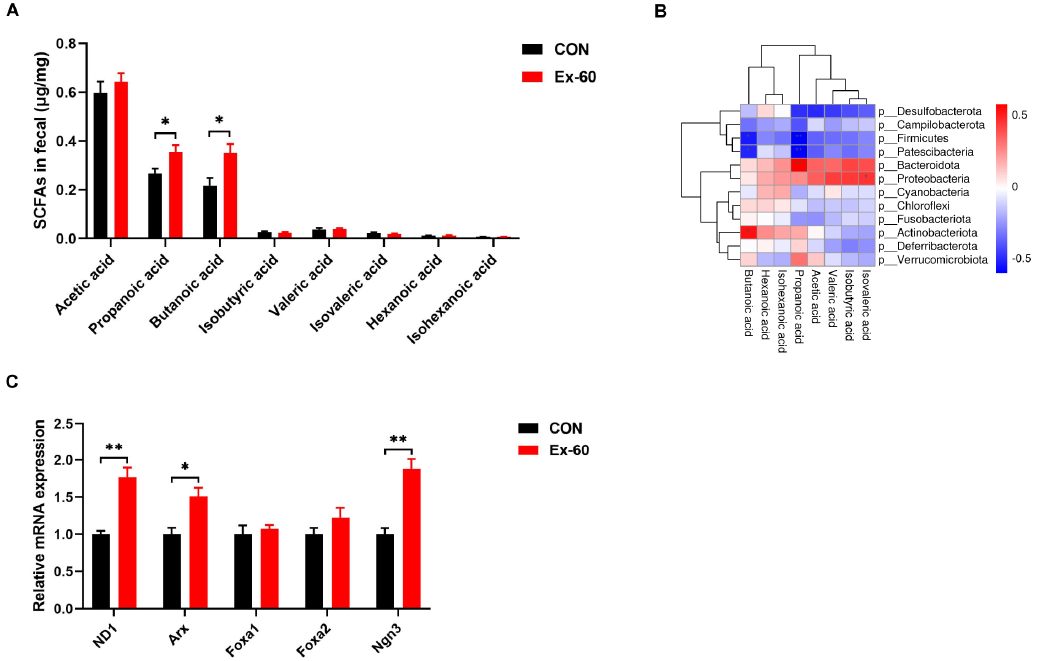
Figure 4. Two ‐ week swimming training alters short ‐ chain fatty acid profile. ( A ) SCFAs content in fecal samples, n = 8–10. ( B ) Pearson correlation analysis of SCFAs with gut microbiota on phylum level. Red indicates a positive correlation, blue indicates a negative correlation, and white indicates no correlation. ( C ) qPCR analysis of the expression of the regulators of L cell proliferation in colon samples. Data are expressed as the mean ± SEM. Unpaired t ‐ test: ( A , C ). * p < 0.05, and ** p < 0.01.